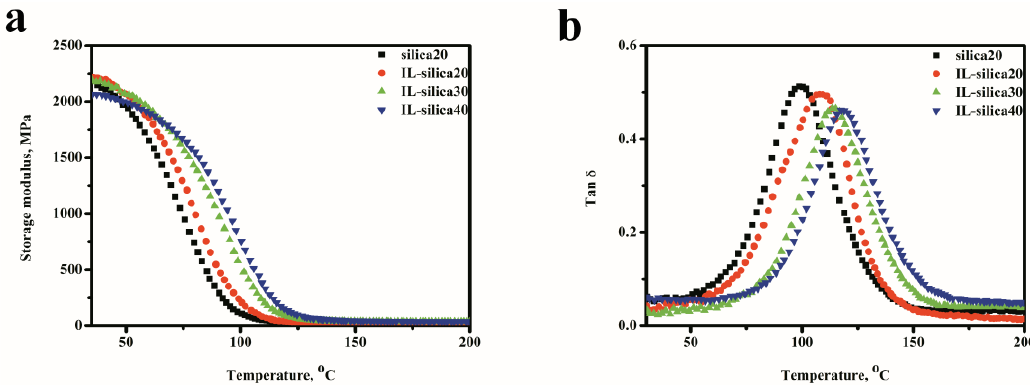
Figure 6. Dynamic mechanical properties of epoxy composites containing u-silica and IL-silica. ( a ) Storage modulus; ( b ) tan δ.